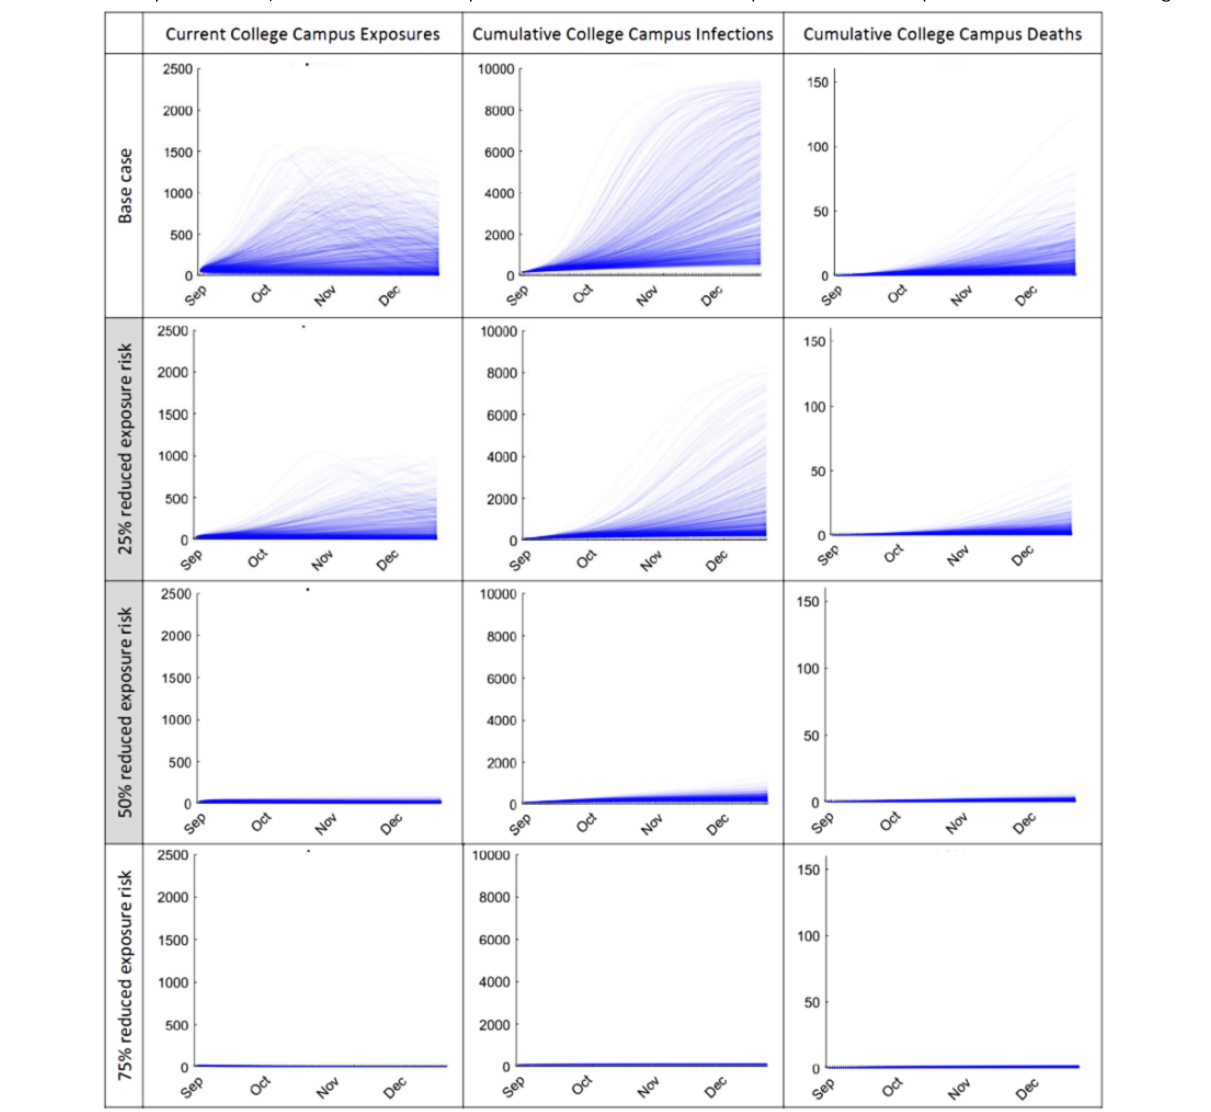
Figure 2. Relative effectiveness of reopening and precaution strategies on reducing college campus student COVID-19 exposures at any given date, total infections to date, and total mortality to date per 10,000 students (fall 2020 semester, assuming 1% of students are infected or exposed at the start of the semester, urban university example). Top row: base case from Figure 1 for comparison; shaded middle rows (most likely cases): realistic precaution effectiveness and compliance cases; bottom row: idealistic precaution effectiveness and compliance. Reduced exposure risk refers to reducing